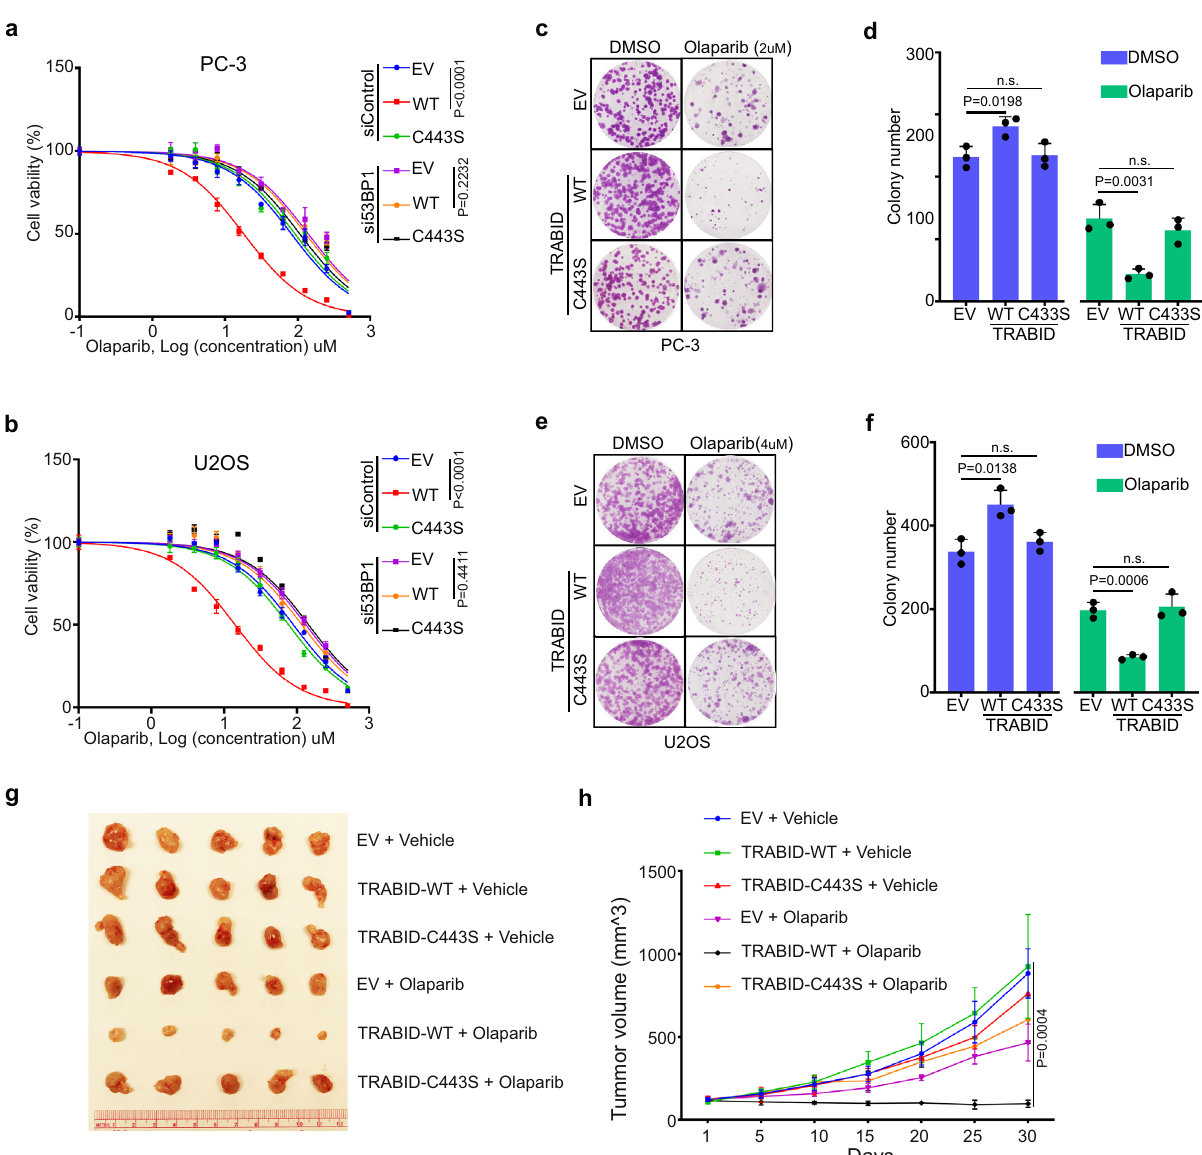
Fig.6|TRABIDoverexpressionenablessyntheticlethalitytoPARPinhibitorin prostate cancer cells. a , b Dose-response survival curves of EV, TRABID-WT, and TRABID-C443S-expressing cells combine with siControl or si53BP1 exposed to increasing concentrations of olaparib in PC-3 ( a ) and U2OS ( b ) cells. Data were shown as the mean±SD of three independent experiments ( n =3). Statistical ana- lysis was performed using two-way ANOVA. P value were provided in the fi gure. c – f ColonyformationassayswereperformedinPC-3( c , d )andU2OS( e , f )celllines infectedwithlentivirusexpressingEV,TRABID-WT,orTRABID-C443S.Thenumber of colonies was counted. Representative colonies are shown in ( c , e ), with